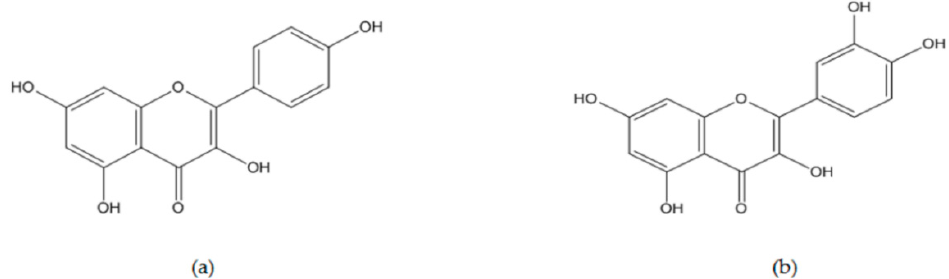
Figure 3. Chemical structures of kaempferol and quercetin belonging to flavonoids from Orosta- chys japonica : ( a ) Kaempferol (3,5,7-trihydroxy-2-(4-hydroxyphenyl)-4H-1-benzopyran-4-one, C 15 H 10 O 6 , molecular mass 286.23 g/mol), and ( b ) quercetin (3,3 ′ ,4 ′ ,5,7-pentahydroxyflavone C 15 H 10 O 7 , molecular mass 302.236